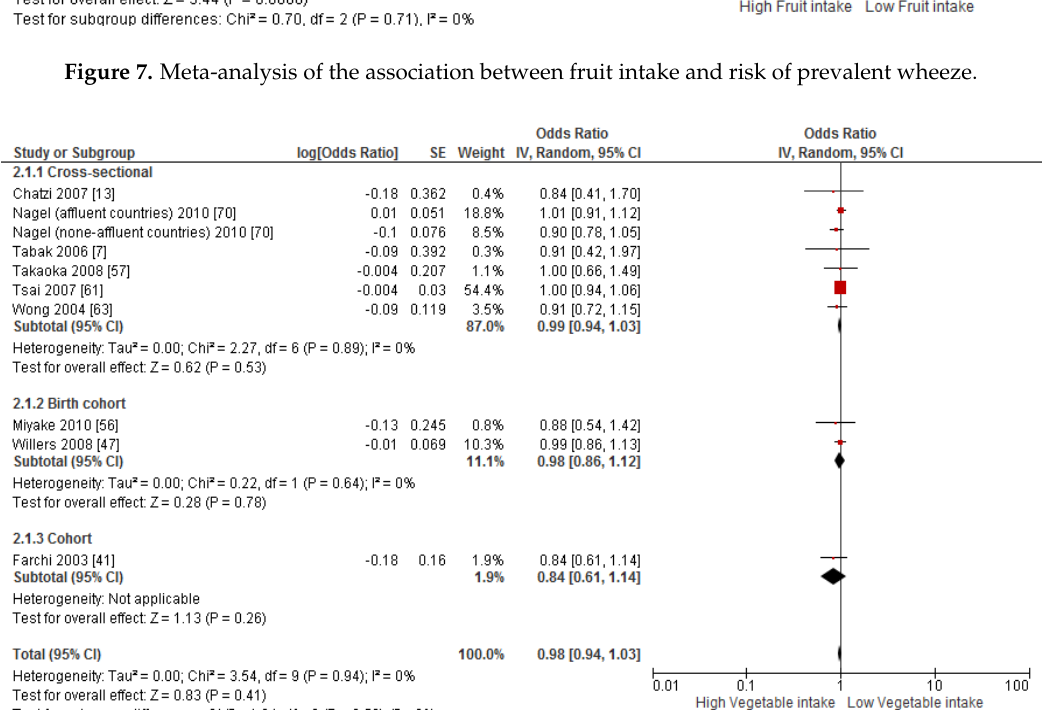
Figure 9. Meta ‐ analysis of the association between fruit and vegetable intake and risk of prevalent asthma. 4. Discussion This systematic review and meta ‐ analysis is the first aimed at investigating the effects of fruit and vegetable consumption on risk of asthma and wheezing and immune responses (including immune responses to virus infection and inflammation) in asthma and wheezing. We found that the majority of studies ( n = 8 in adults and n = 22 in children) reported a protective effect of a high fruit and vegetable diet on asthma and/or wheeze. Twenty studies ( n = 8 in adults and n = 12 in children) reported mixed results, as they found a negative association between intake of fruit only or vegetable only and risk of asthma and/or wheeze. Eight studies ( n = 1 in adults and n = 7 in children) failed to show any beneficial effects of fruit and vegetable intakes on risk of asthma and wheeze. In the meta ‐ analysis, fruit intake was not associated with the risk of prevalent asthma ( p > 0.05); however, a negative relationship was observed between consumption of fruit and asthma severity.